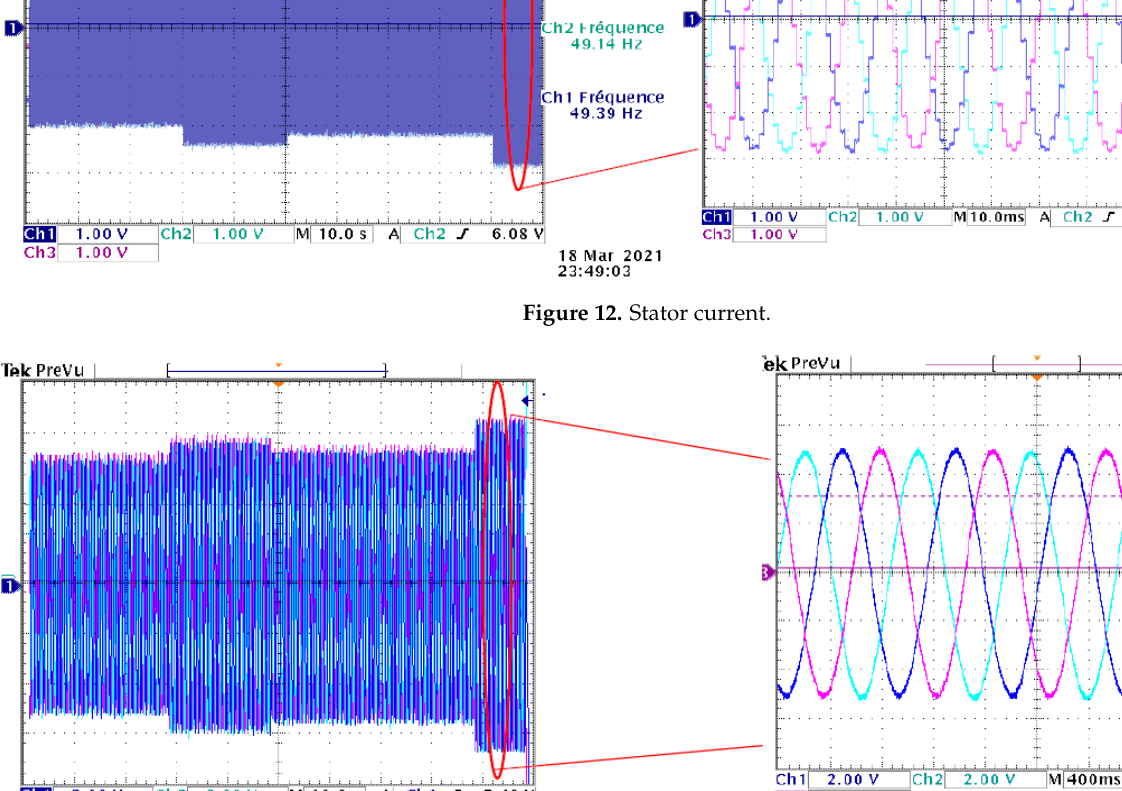
Figure 13. Rotor Figure 13. Rotor current. Figure 13. Rotor current.